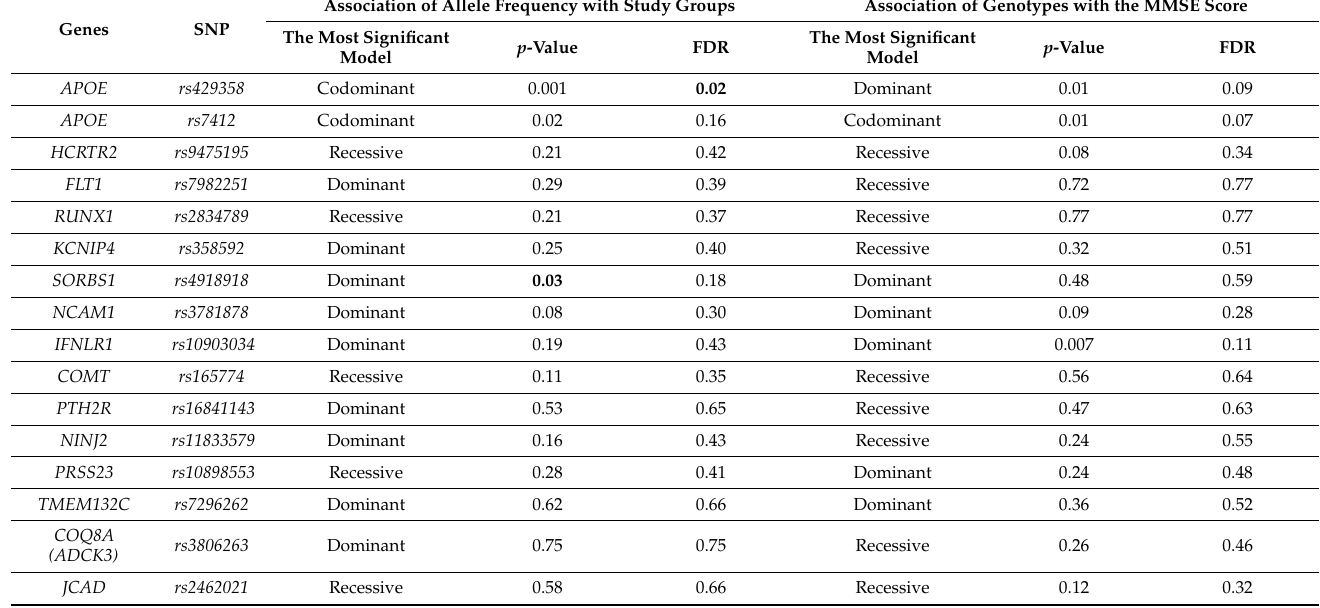
Table 4. Analysis of allele frequency association with study groups and association between geno- types and the MMSE score. Age was used as a